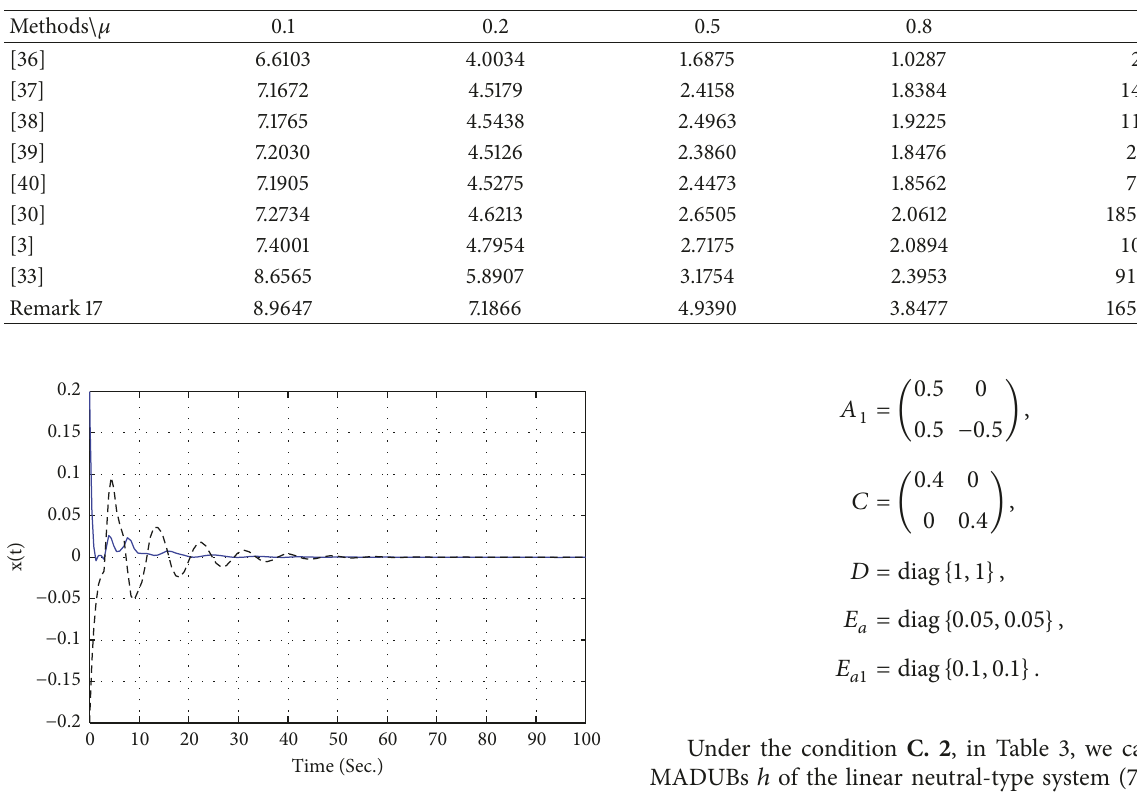
Table 4: MADUBs ℎ for different 𝜇 (Example 4).